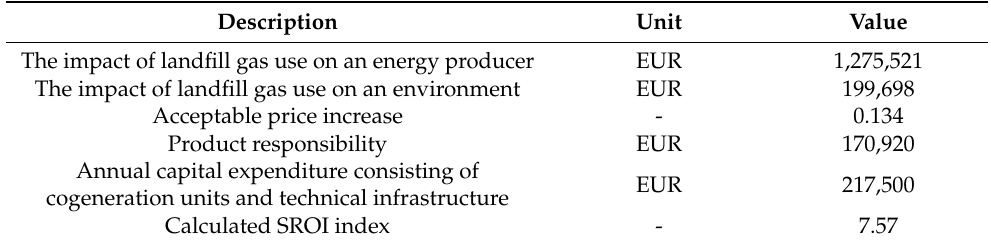
Table 8. Summary of input data and calculation results for the determination of social